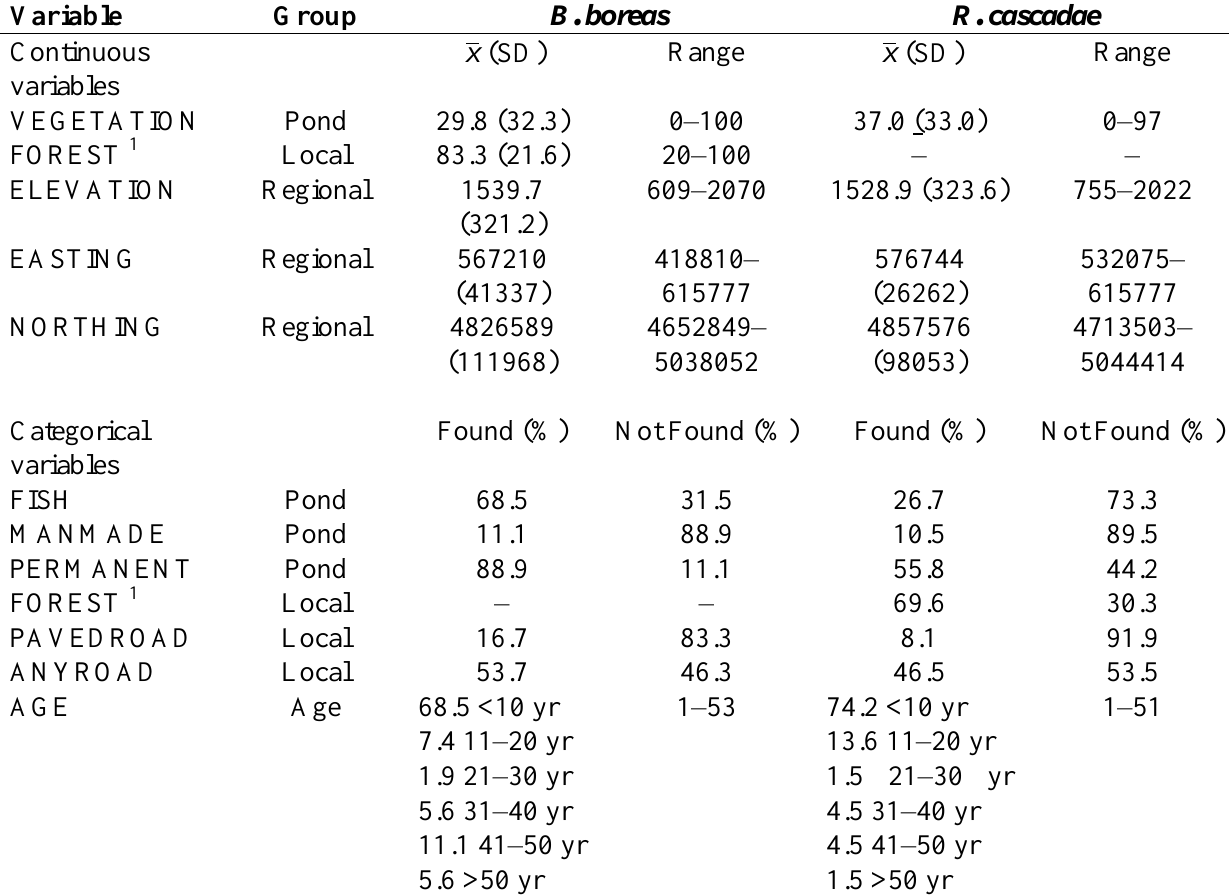
Table 1. Site variables assessed as covariates of detectability or occupancy for B. boreas (N = 54) and R. cascadae (N = 66) historical breeding sites in the Cascade Range, Oregon, USA. Continuous variables are expressed as x (SD) and Range. Categorical variables